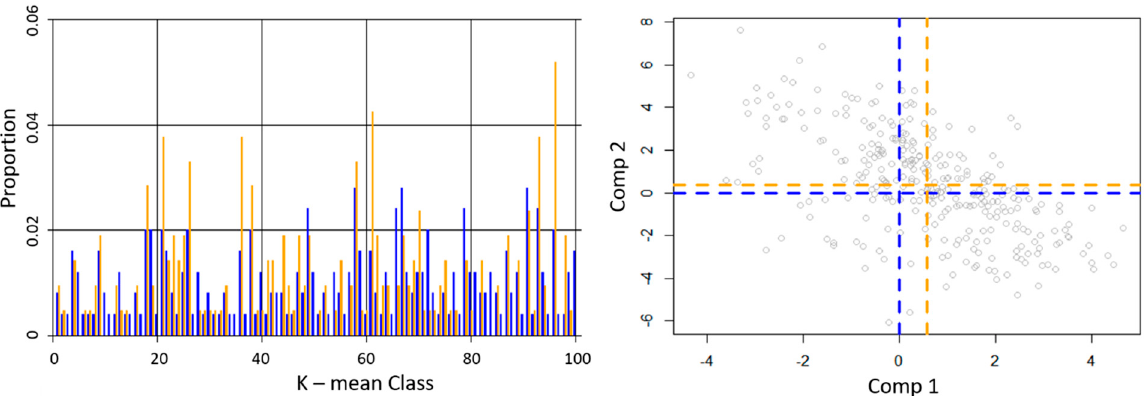
Figure 4. Distribution of field plots in predictor variables space. The proportion of observations within each K-mean class is displayed for the spatially balanced (blue) and field samples (orange) in the left graphic while the mean (dashed lines) and location of field plots (grey points) in projected principal component space are displayed in the right graphic.